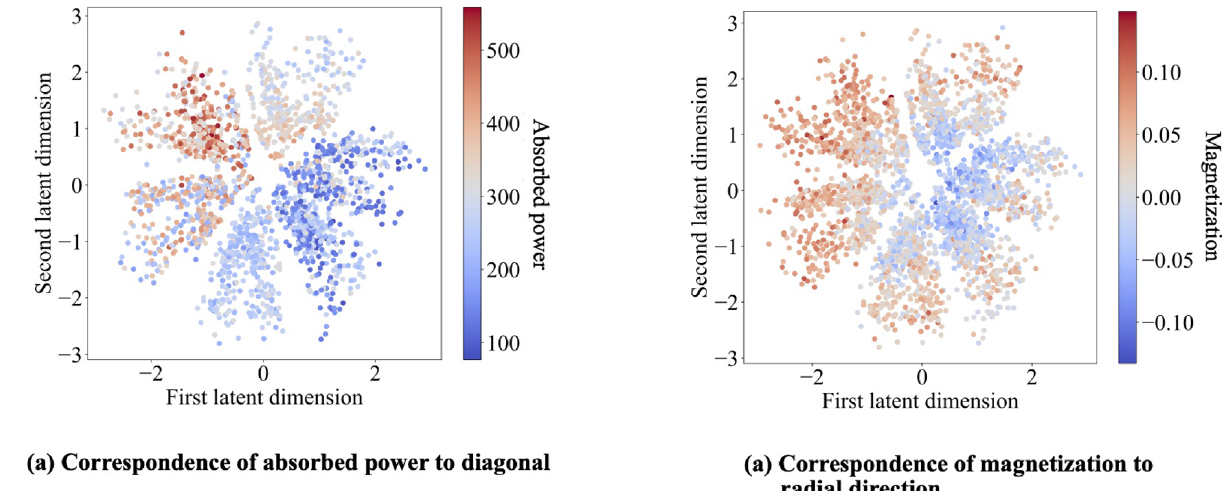
Figure 5. Correspondence of latent-space directions to thermodynamic quantities: A variational autoencoder trained on the configurations assumed by a spin glass exposed to fields A , B , and C . We have color-coded each latent-space plot, highlighting how a thermodynamic property changes along some direction. In ( a ), the absorbed power grows from the bottom righthand corner to the upper lefthand corner. In ( b ), the magnetization grows